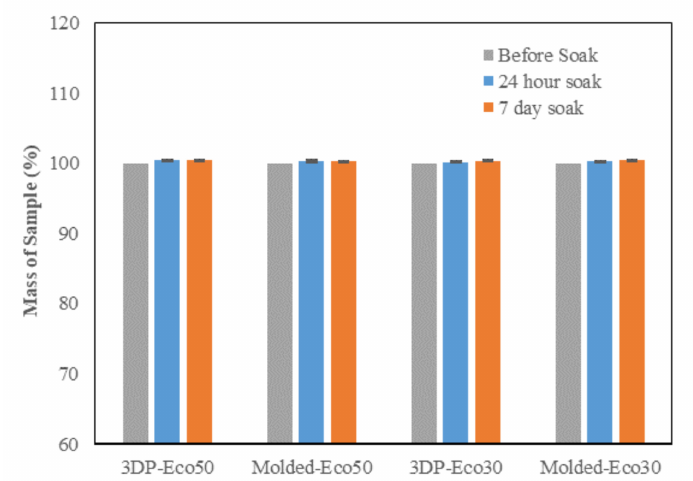
Figure 7. Phosphate bu ff er absorption test for silicone meniscus implants Ecoflex 50 and